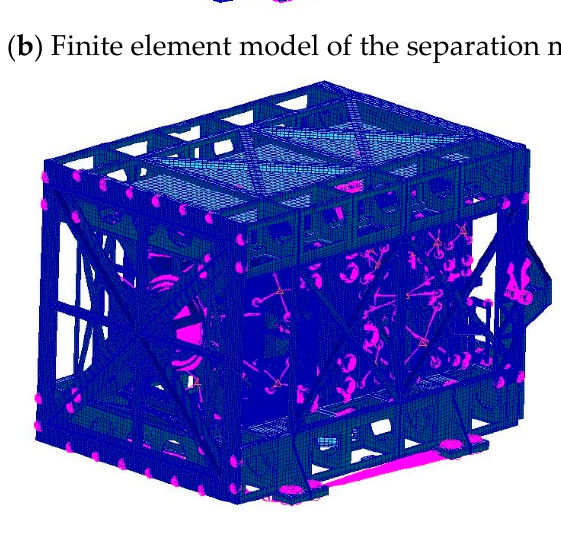
Figure 7. Finite element analysis model.